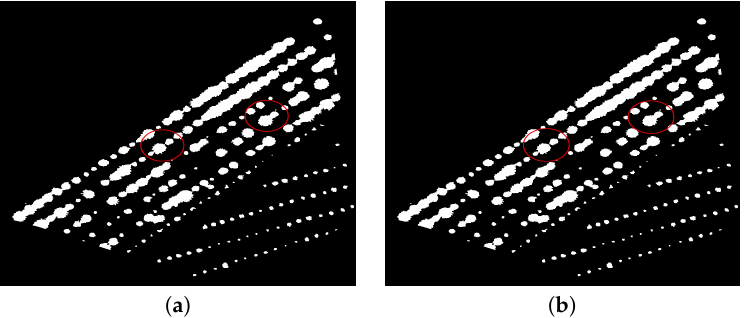
Figure 10. Results of applying opening and closing operators: ( a ) image obtained from opening and ( b ) closing morphological operators.